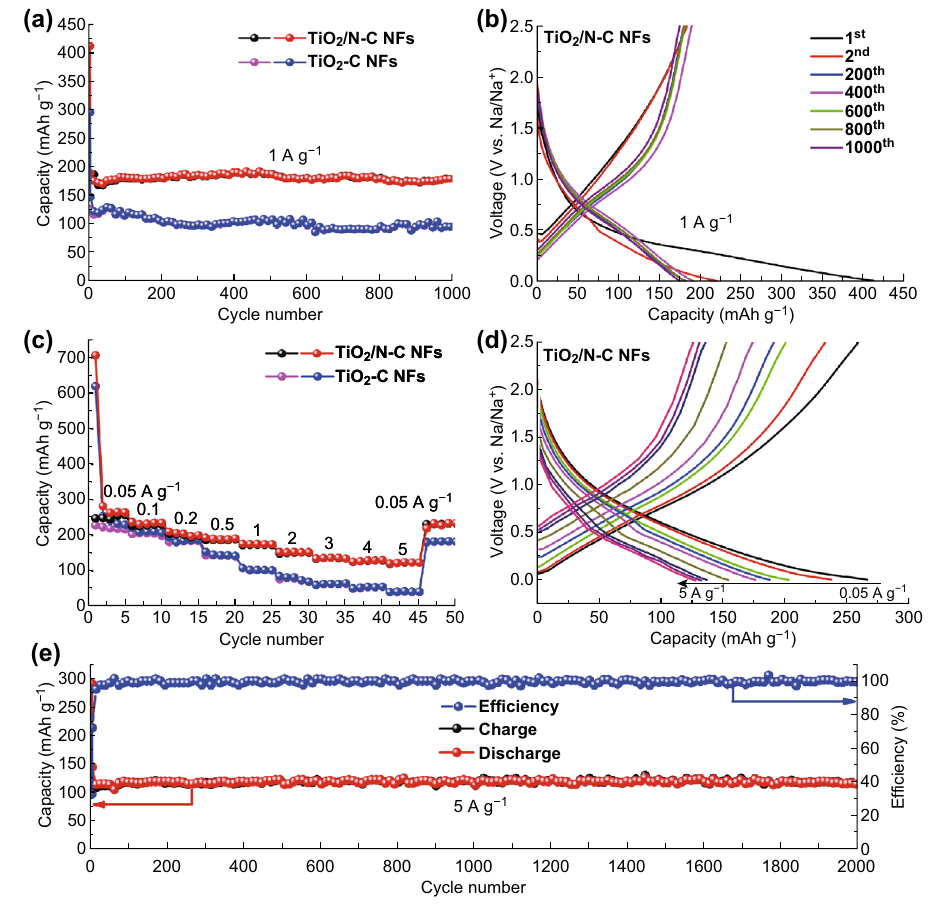
Fig. 3 a Cycling performance of the TiO 2 /N–C NF and TiO 2 –C NF electrodes under a current density of 1 A g - 1 . b Continuous discharge and charge curves of TiO 2 /N–C NF electrode under a current density of 1 A g - 1 . c Rate capability of TiO 2 /N–C NFs and TiO 2 /C NFs. d Charge– discharge curves of TiO 2 /N–C NFs at 0.05–5 A g - 1 in the range of 0.01–2.5 V. e Long-term cycle performance of TiO 2 /N–C NFs under a high current density of 5 A g - 1